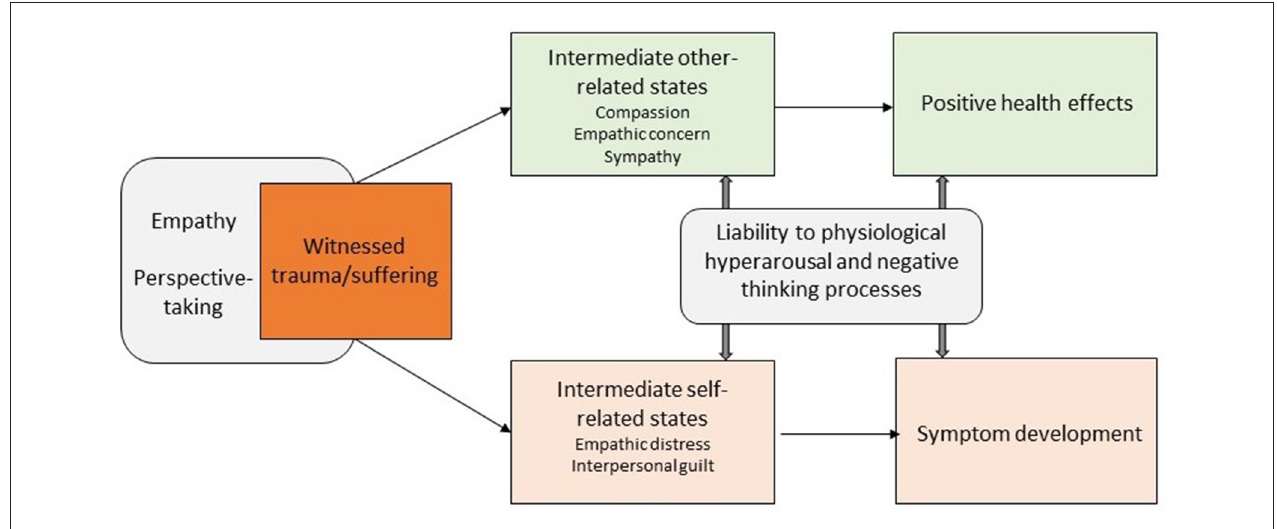
FIGURE 1 | Proposed socio-affective and socio-cognitive mechanism and pathways in the processing of witnessed traumatic events [based on (37,